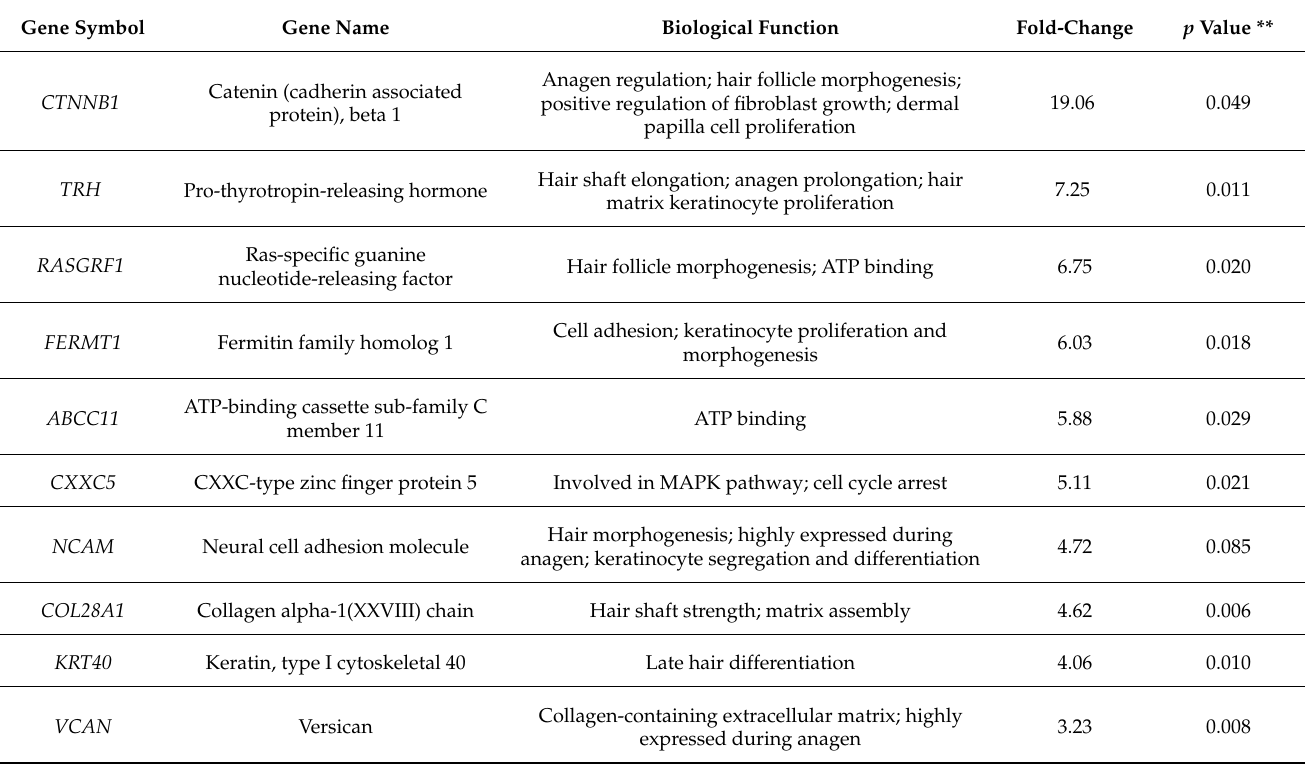
Table 2. The top upregulated genes in the 3D minoxidil-treated cells (vs. 3D control) *.